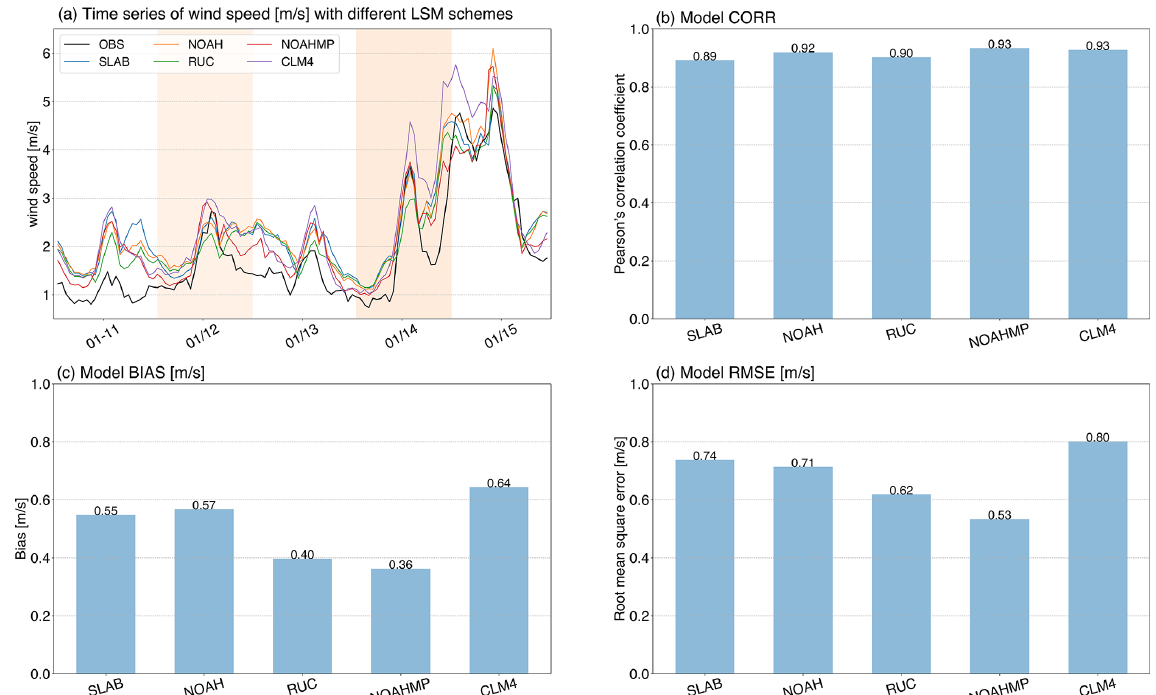
Figure 15. Same as Fig. 3 but for simulations with different land surface schemes. The PBL, MP, and SW–LW schemes used are the same as the simulation with the best Taylor skill score (WDM6 in Fig. 10).